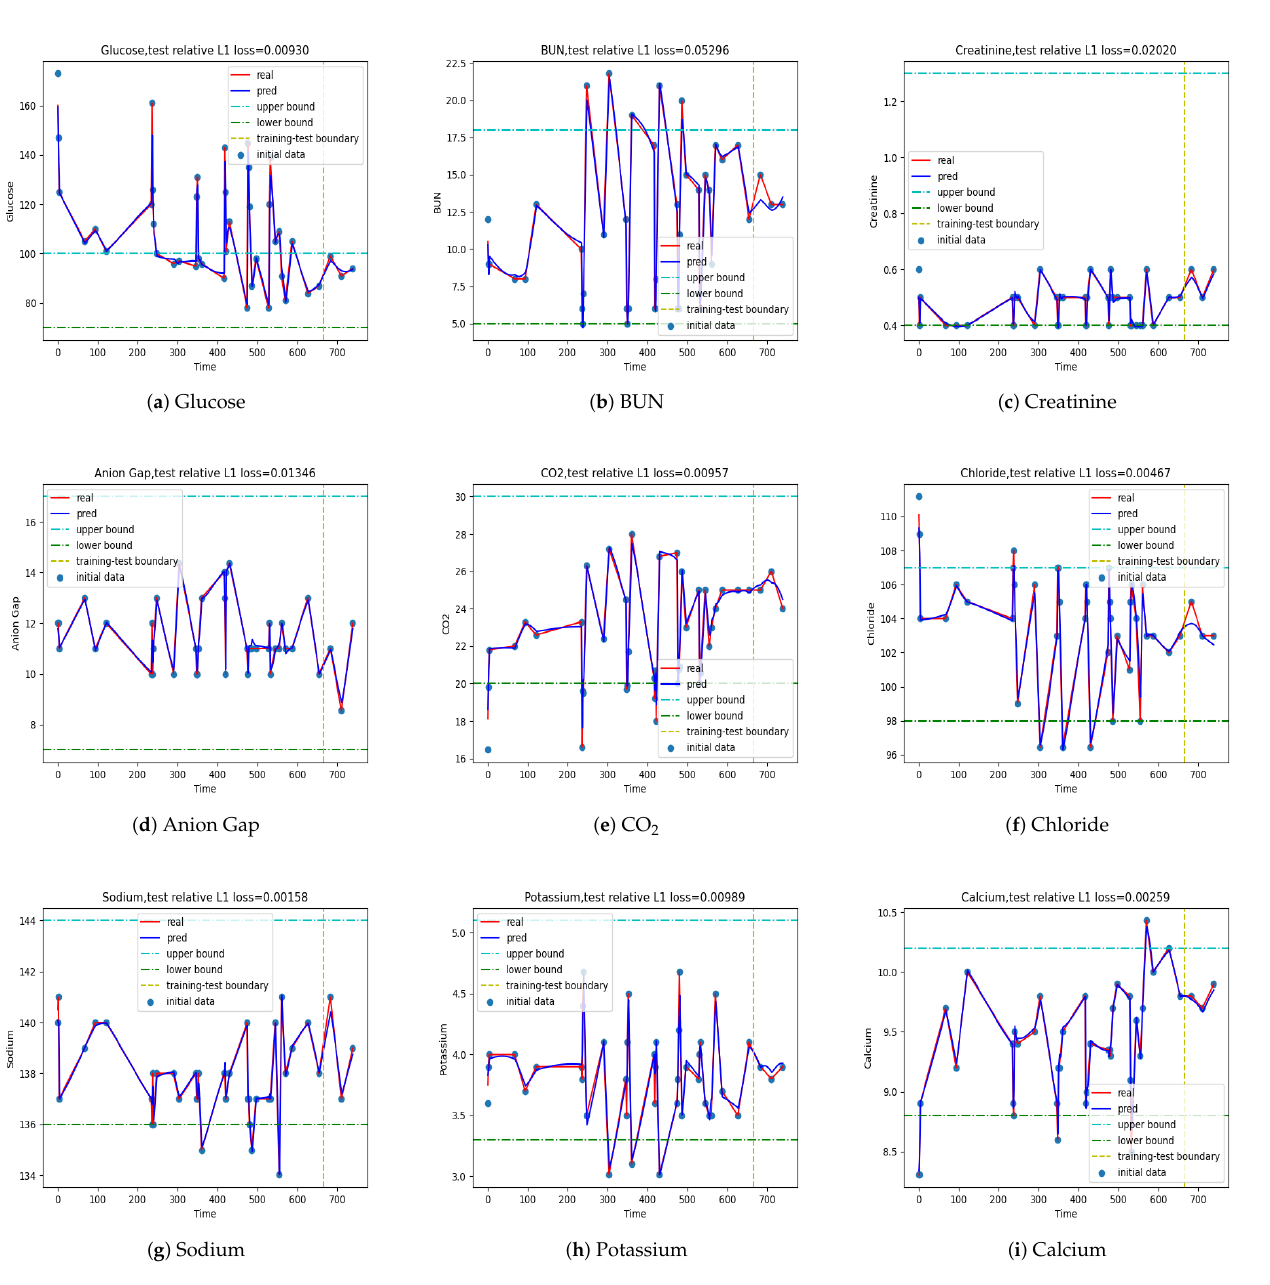
Figure 5. Output { ˆ x T + L + i − 1 , i = 1, · · · , } at T = 1, L = 1. The ones used in training are plotted on the left of the vertical line and the predicted ones on the